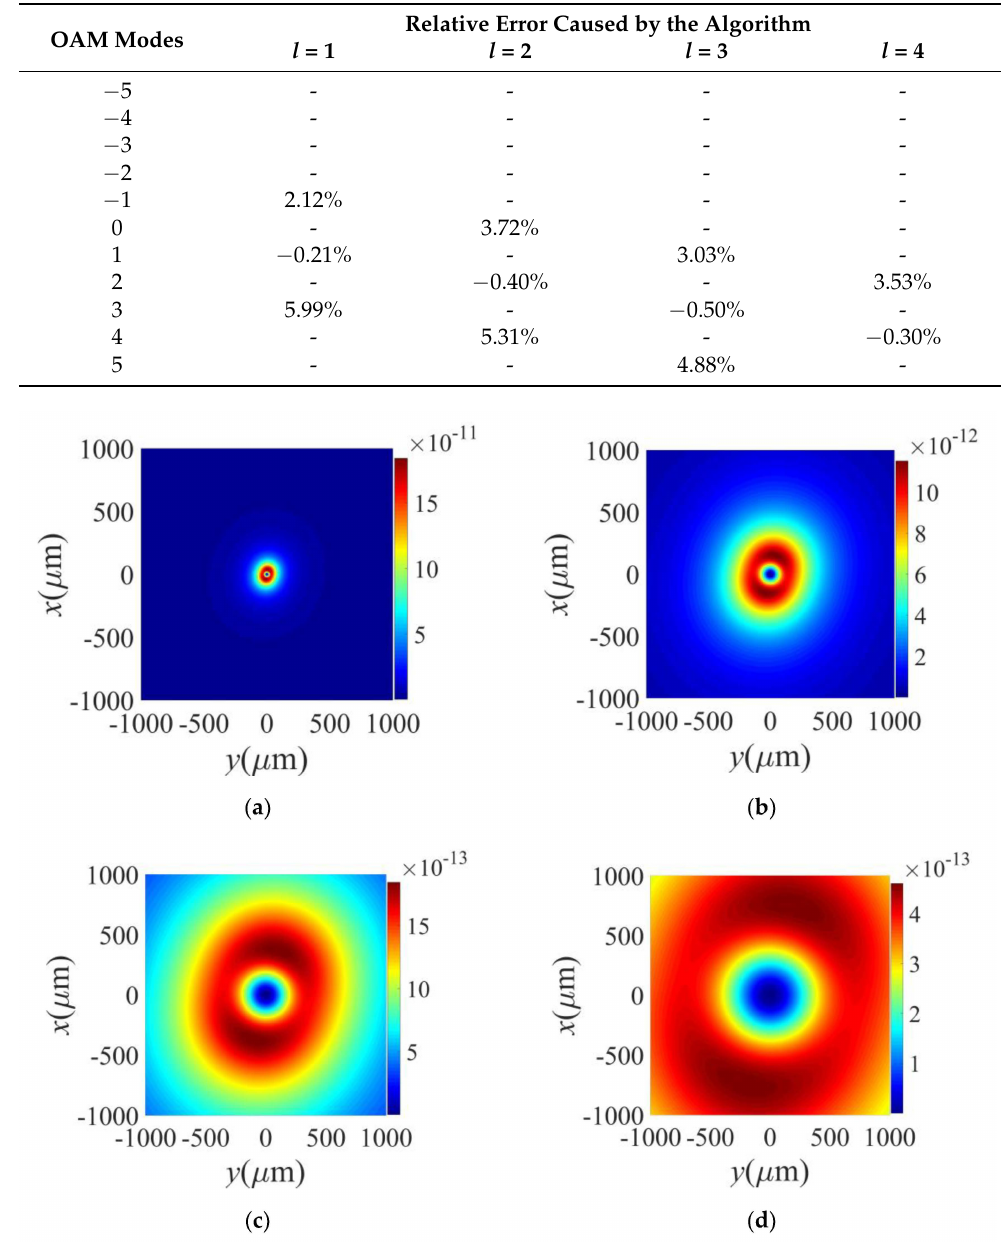
Table 1. Relative error in the detection probability of the OAM modes at the source and at z = 50 µ m for the incident field with topological charge l . Detection errors are caused by the calculation algorithm of the field.